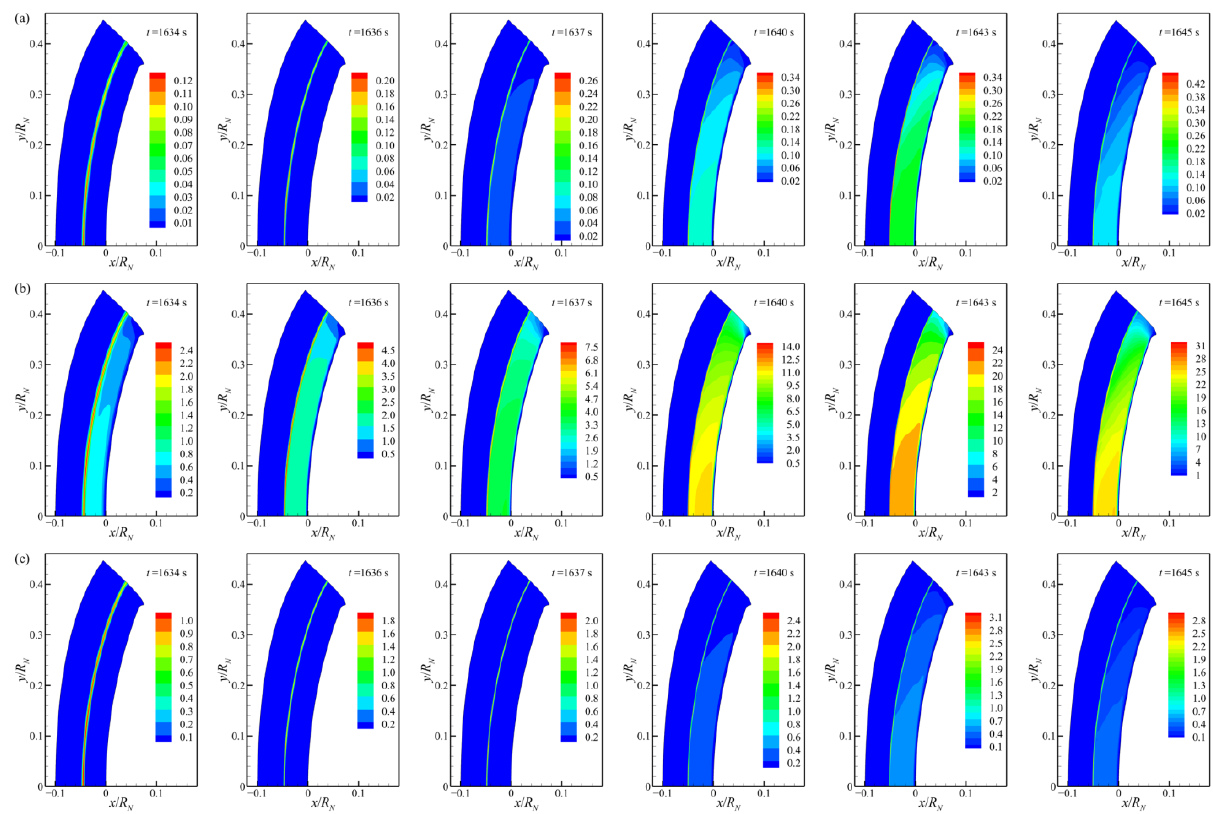
Figure 9. Planck-mean absorption coefficient throughout the trajectory (unit: m −1 ): ( a ) two-step model; ( b ) five-step model; ( c ) eight-step model.